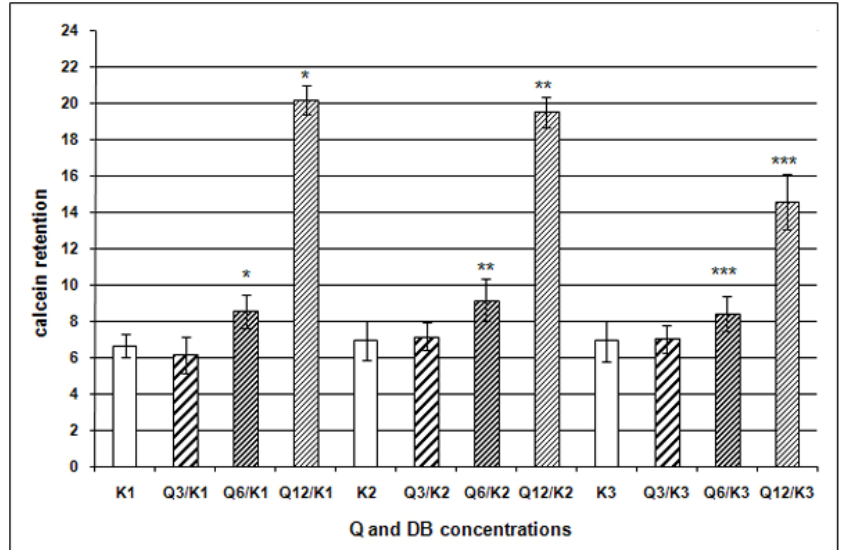
Figure 5. Retention of calcein in cells of EPP85-181RDB line following administration of Q and DB combination, as compared to action of DB alone; * p < 0.001 as compared to K1; ** p < 0.001 as compared to K2; *** p < 0.001 as compared to